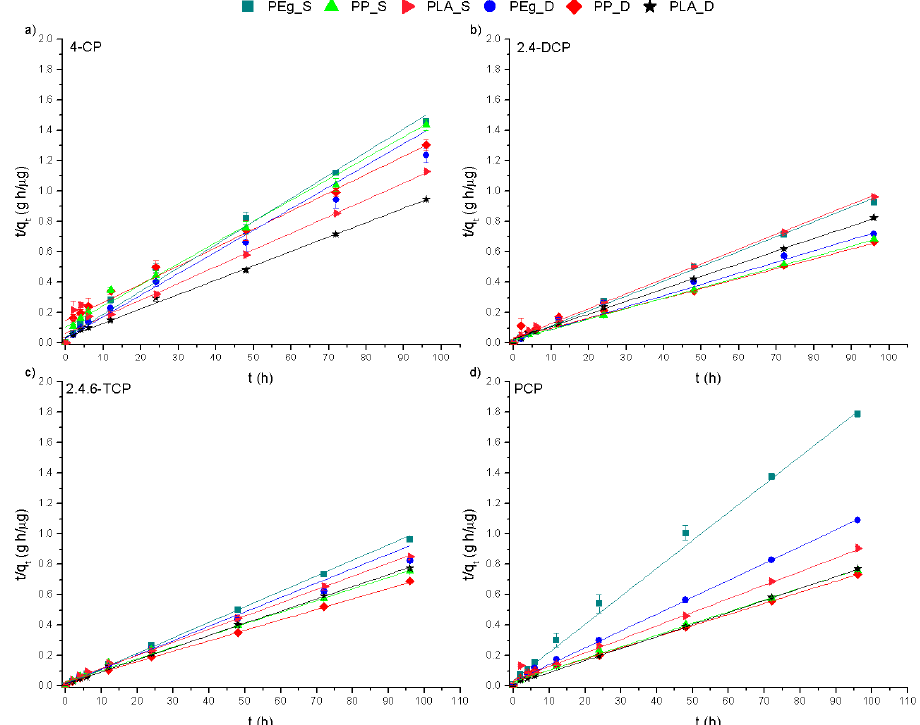
Figure 2. Plots for the sorption kinetics, based on the pseudo-second order model, of ( a ) 4- CP; ( b ) 2,4-DCP; ( c ) 2,4,6-TCP and ( d ) PCP on PEg, PP and PLA particles in the synthetic matrix (PEg_S, PP_S and PLA_S) and Danube river water (PEg_D, PP_D and PLA_D) ( n = 3, mean value ±